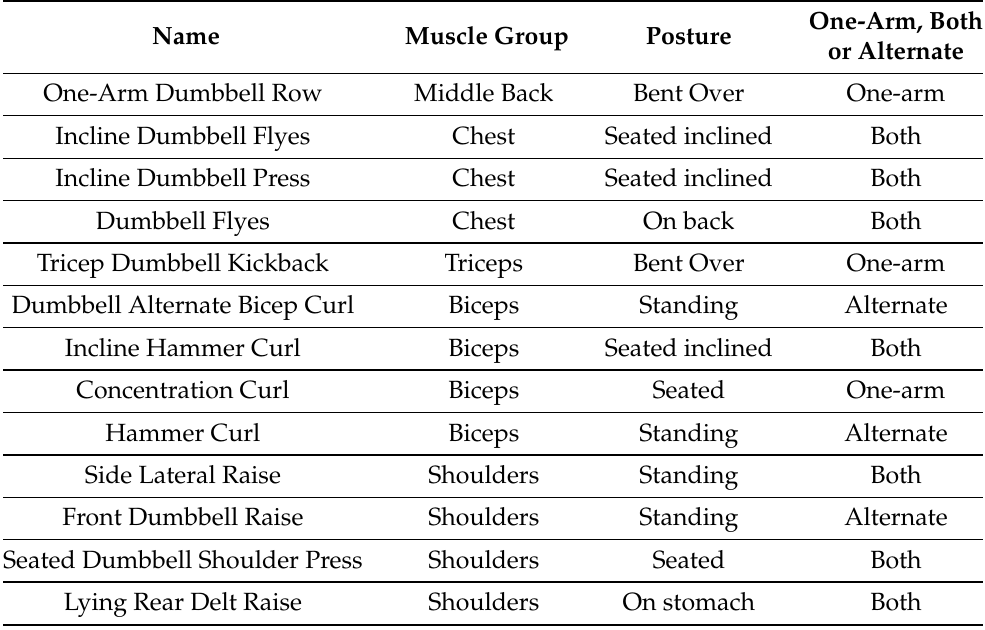
Table 1. A total of 13 dumbbell activities from MyoGym [69] datasets for